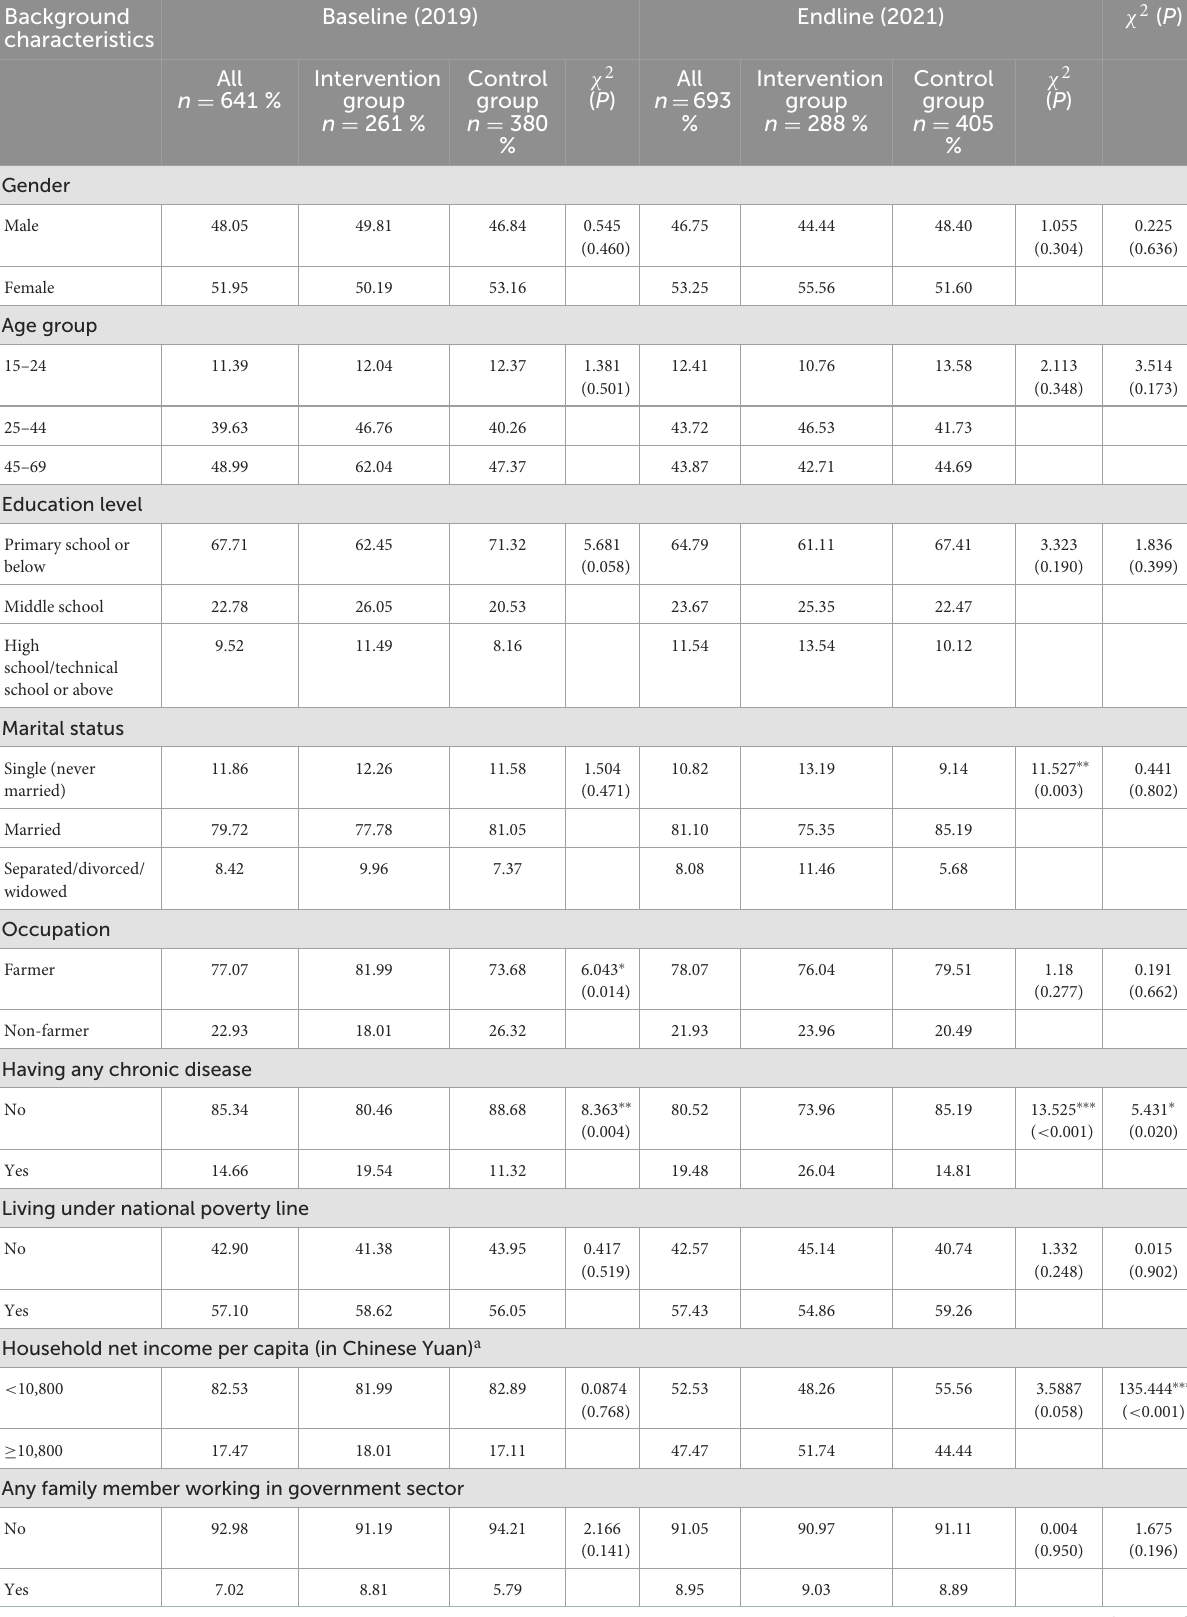
TABLE 2 Differences in socioeconomic and demographic profiles between intervention and control groups at baseline and endline. Background